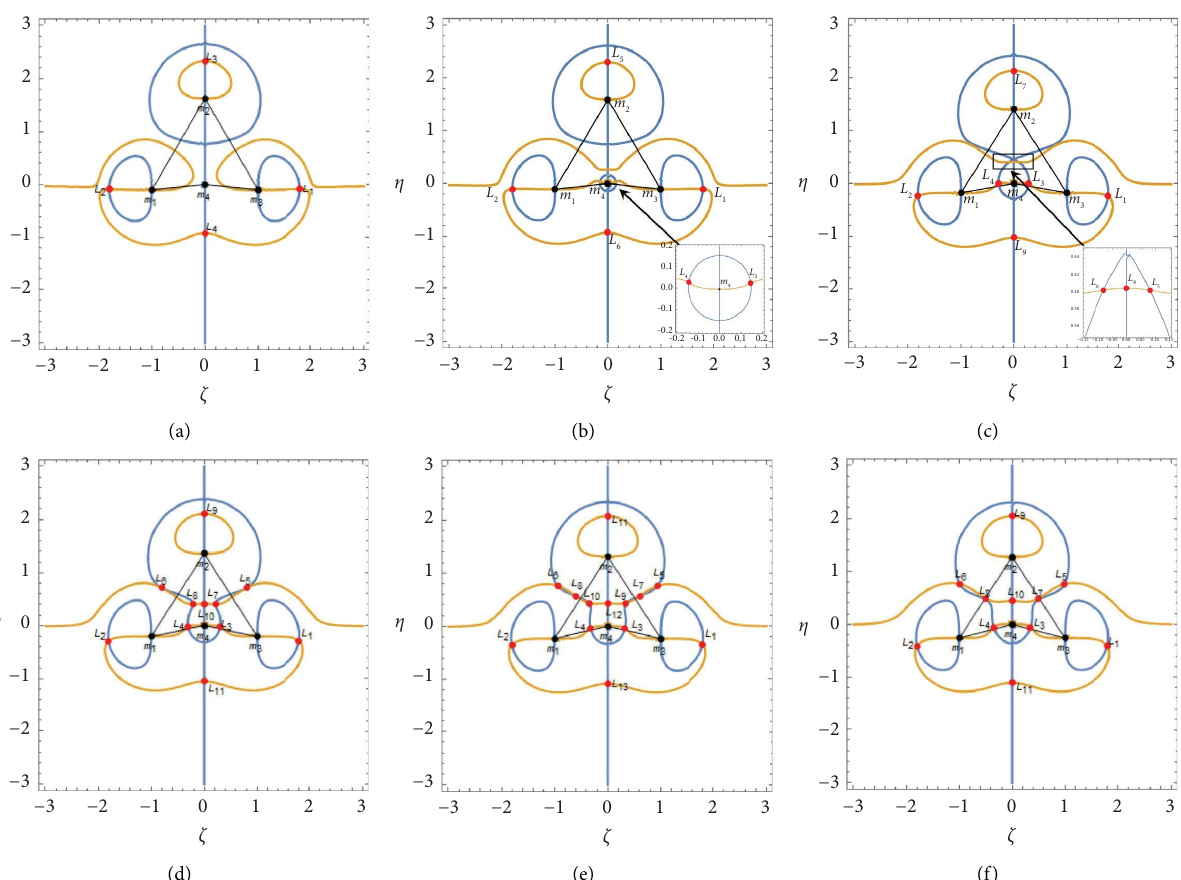
Figure 19: Case III: (a) α � 0 . 1, μ � 0 . 000870568, (b) α � 0 . 11, μ � 0 . 015408, (c) α � 0 . 18, μ � 0 . 110342, (d) α � 0 . 2, μ � 0 . 135761, (e) α � 0 . 23, μ � 0 . 17328, (f) α � 0 . 26, μ � 0 . 210775.